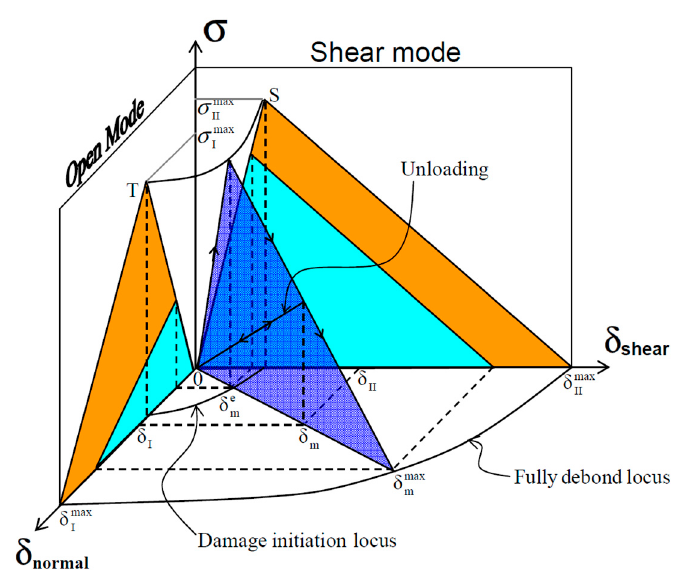
Figure 4. Bilinear traction-separation law of mixed-mode interface failure.